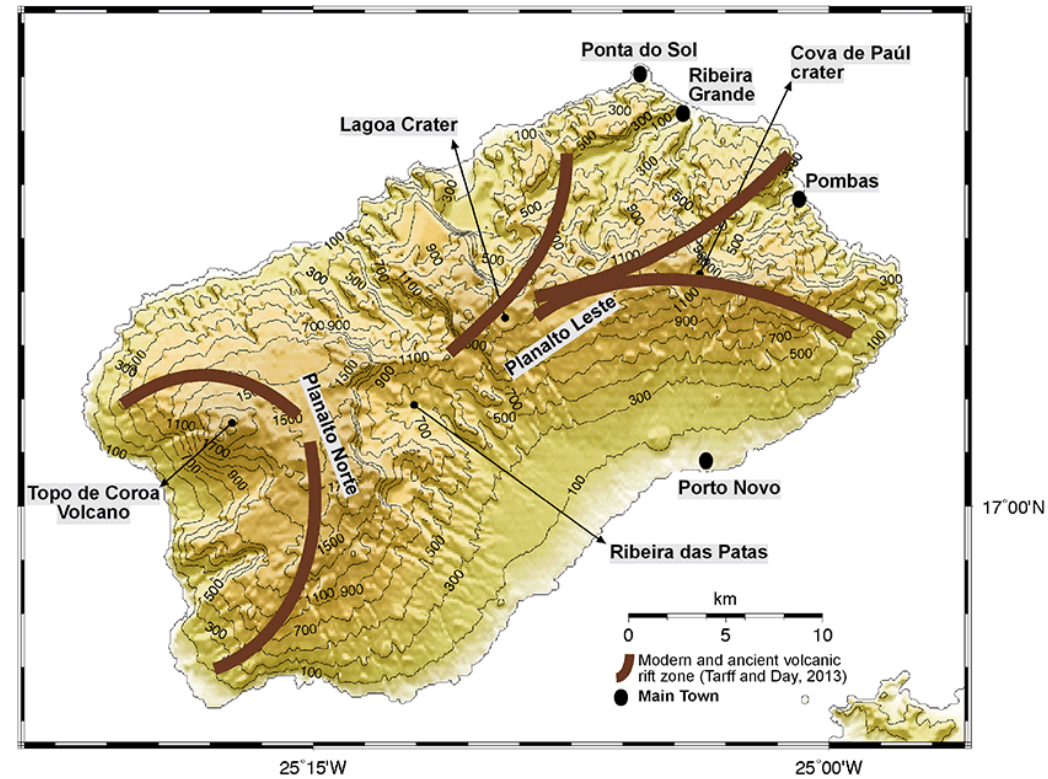
Fig. 3. Topographic map (STRM model) and the main morphologic features of Santo Antão; contour lines are in metres. The locations of the volcanic rift zones are adapted from Tarff and Day